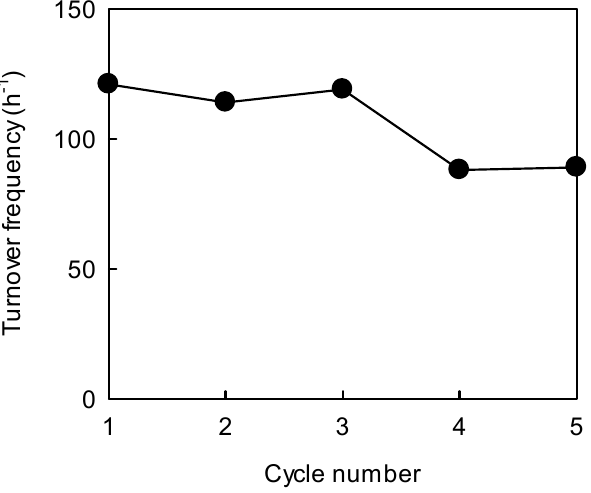
Figure 7. Reusability of AuAgNPs @ ZnO paper in the 4-NP reduction. Total amount of Au and Ag: 0.01 µmol (Au = 0.007 µmol and Ag = 0.003 µmol), 4-NP: 15 µmol, NaBH : 3.0 4